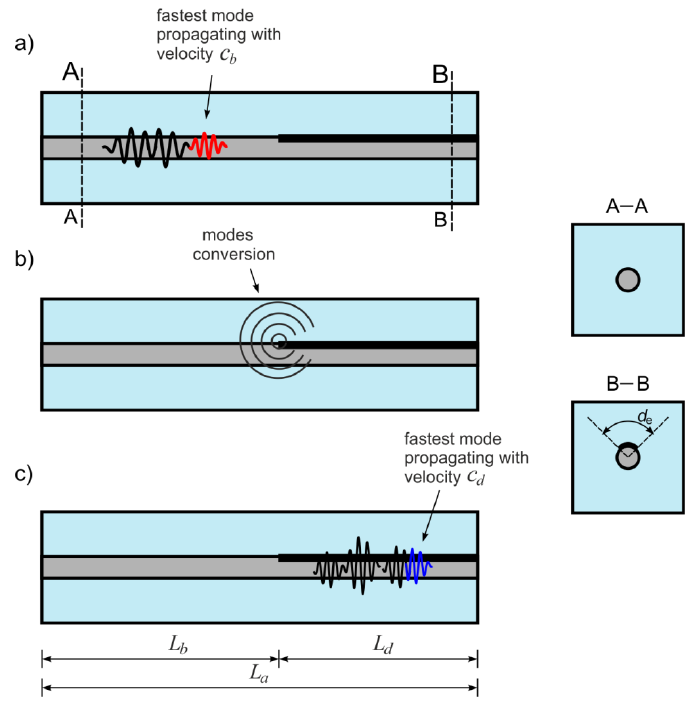
Figure 5. Wave propagation in RC beam with partial debonding: ( a ) wave propagation in undamaged part, ( b ) wave di ff raction at the start of debonding, ( c ) wave propagation along debonded